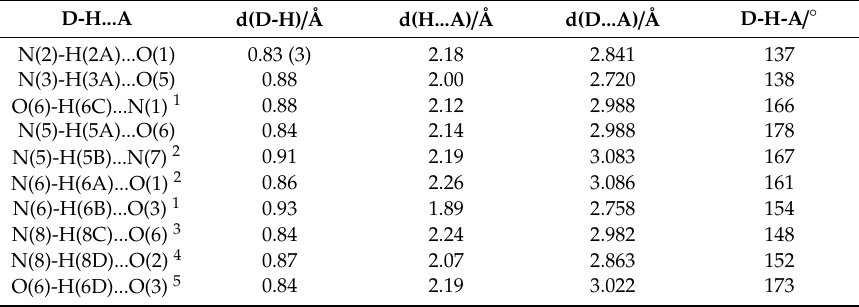
Table 2. Hydrogen bonds for